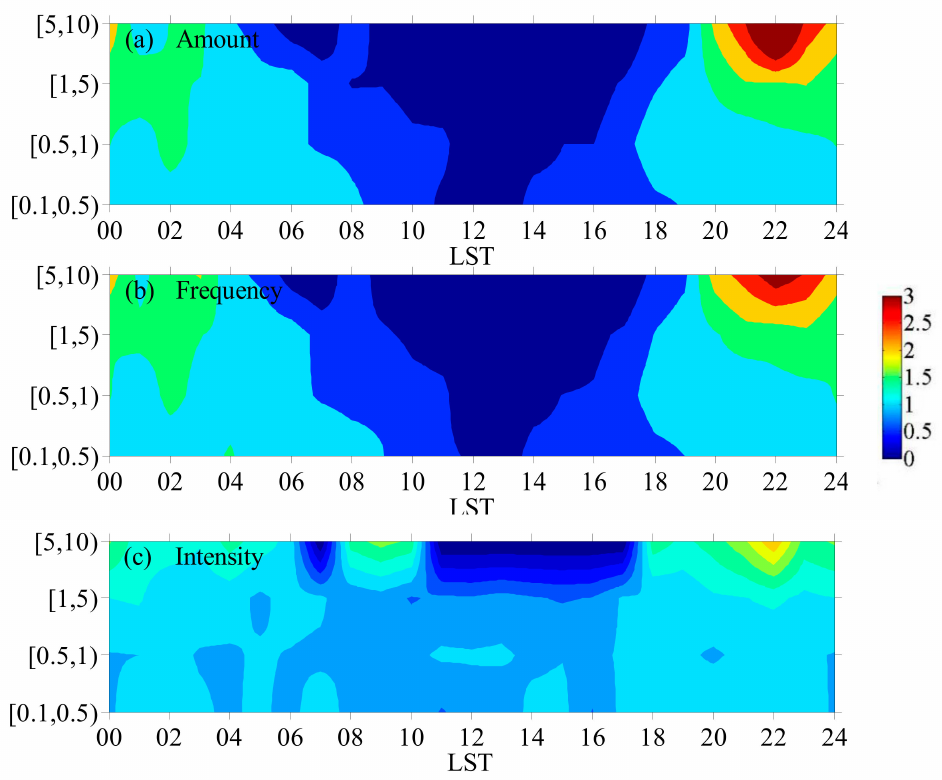
Figure 2. Diurnal variations of precipitation ( a ) amount, ( b ) frequency and ( c ) intensity in different grades obtained from summer hourly precipitation in Jiulong during 2013–2020.